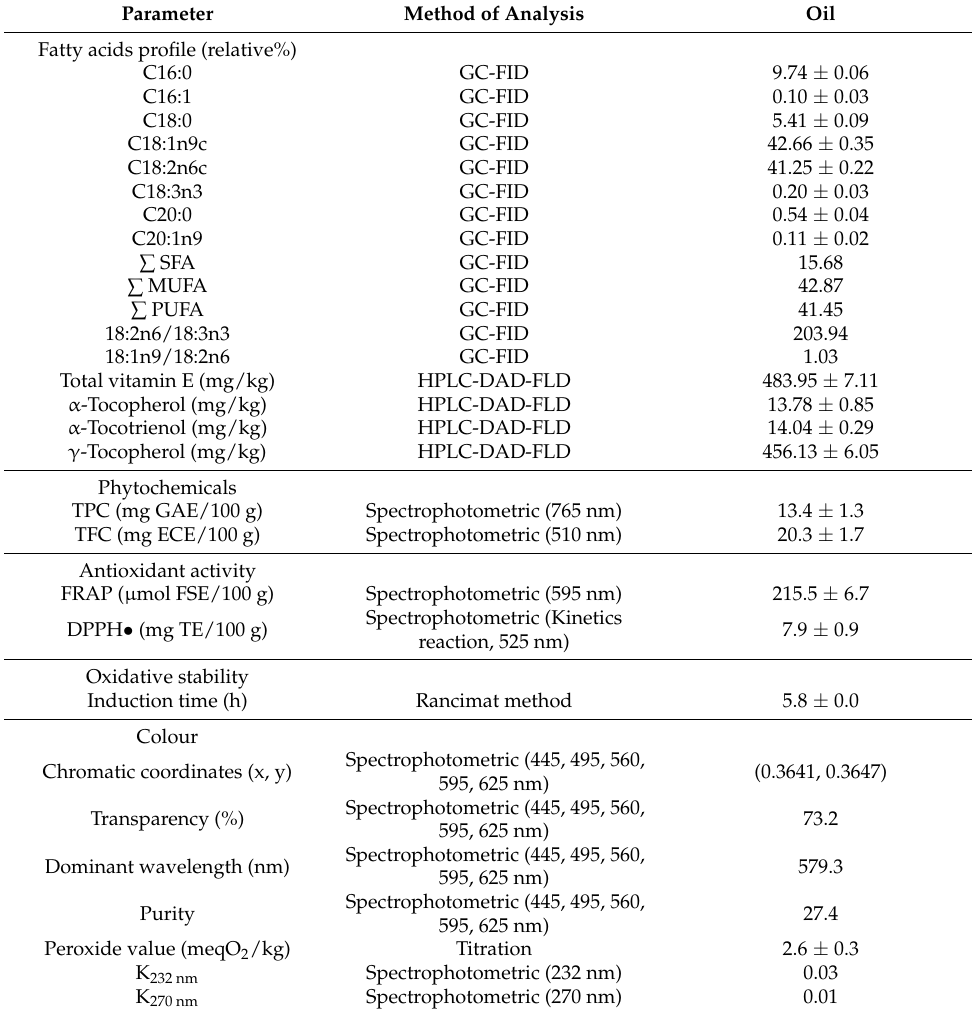
Table 3. Chemical analysis of cold pressed sesame